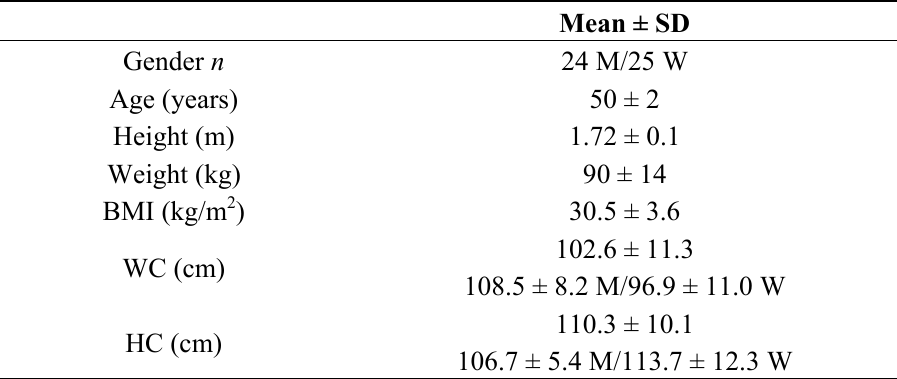
Table 1. Gender, age, anthropometric measurements, body composition, daily dietary intake and energy expenditure of study population at